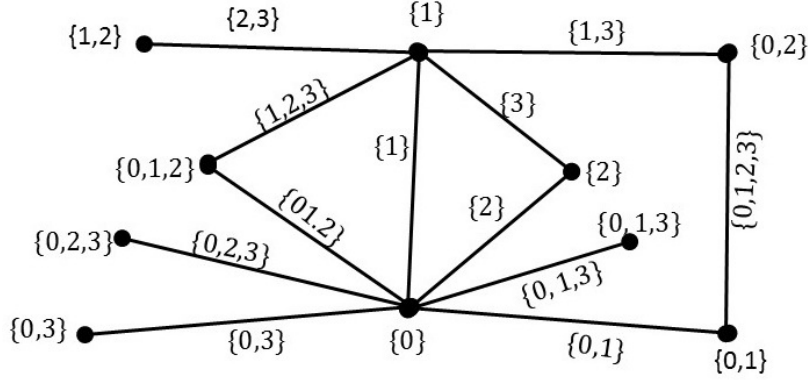
Figure 1. An example of an TIASS-graph which is not a